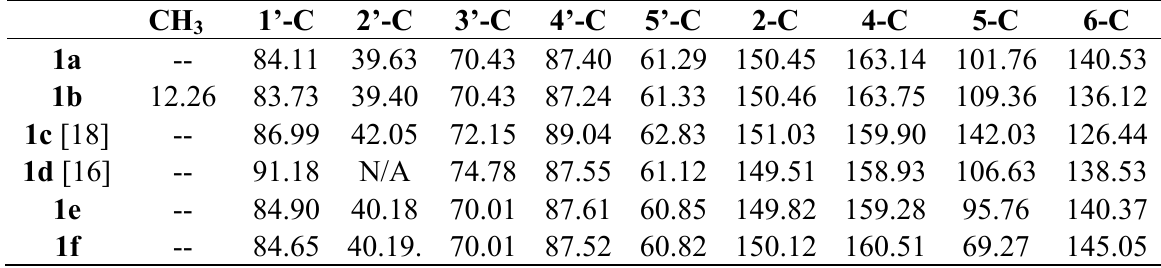
Table 2. 13 C-NMR of 5-Substituted uridine derivatives and their 4-thioanalogues (in DMSO- d